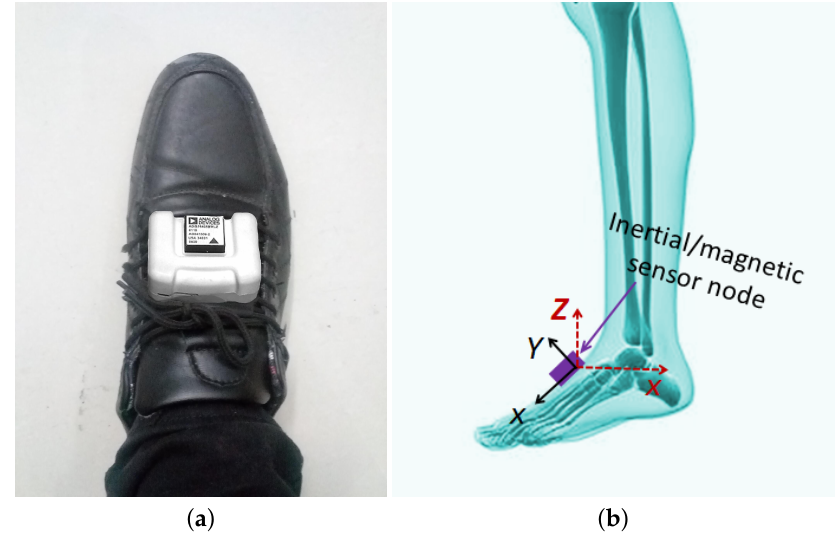
Figure 1. The attachment of a sensor module on the foot of a subject and the illustration of the coordinate systems. The body coordinate system is given in red dashed lines, while the sensor coordinate system is given in black solid